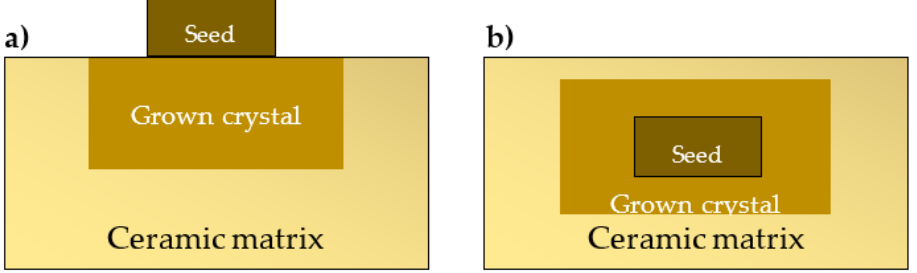
Figure 4. Crystal growth from seed into a cerami c matrix. ( a ) templated growth and ( b ) embedded